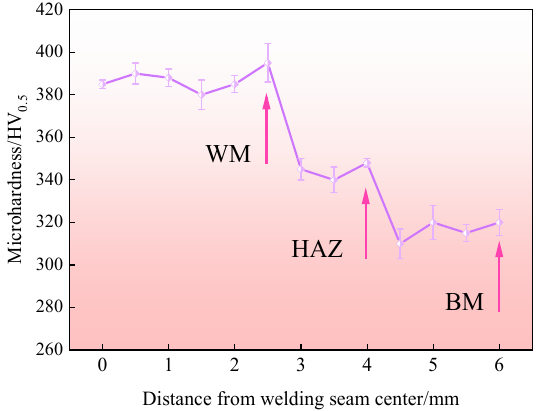
Figure 11. Microhardness distribution of welded